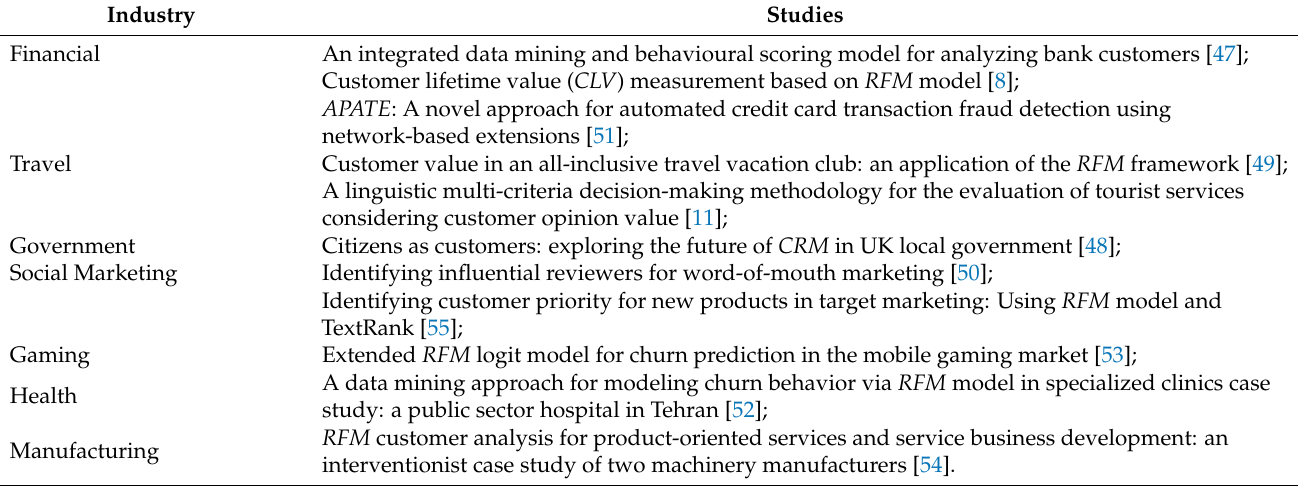
Table 3. CLV Studies and Application to Sectors and Business